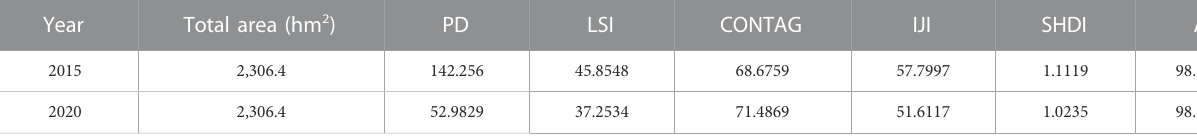
TABLE 6 Landscape pattern indices for 2015 – 2020 landscape levels in the study area.